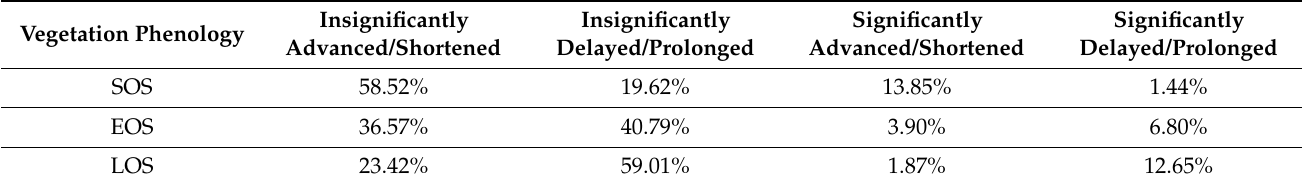
Table 1. The percentage of different trends of vegetation parameters based on MK analysis across the